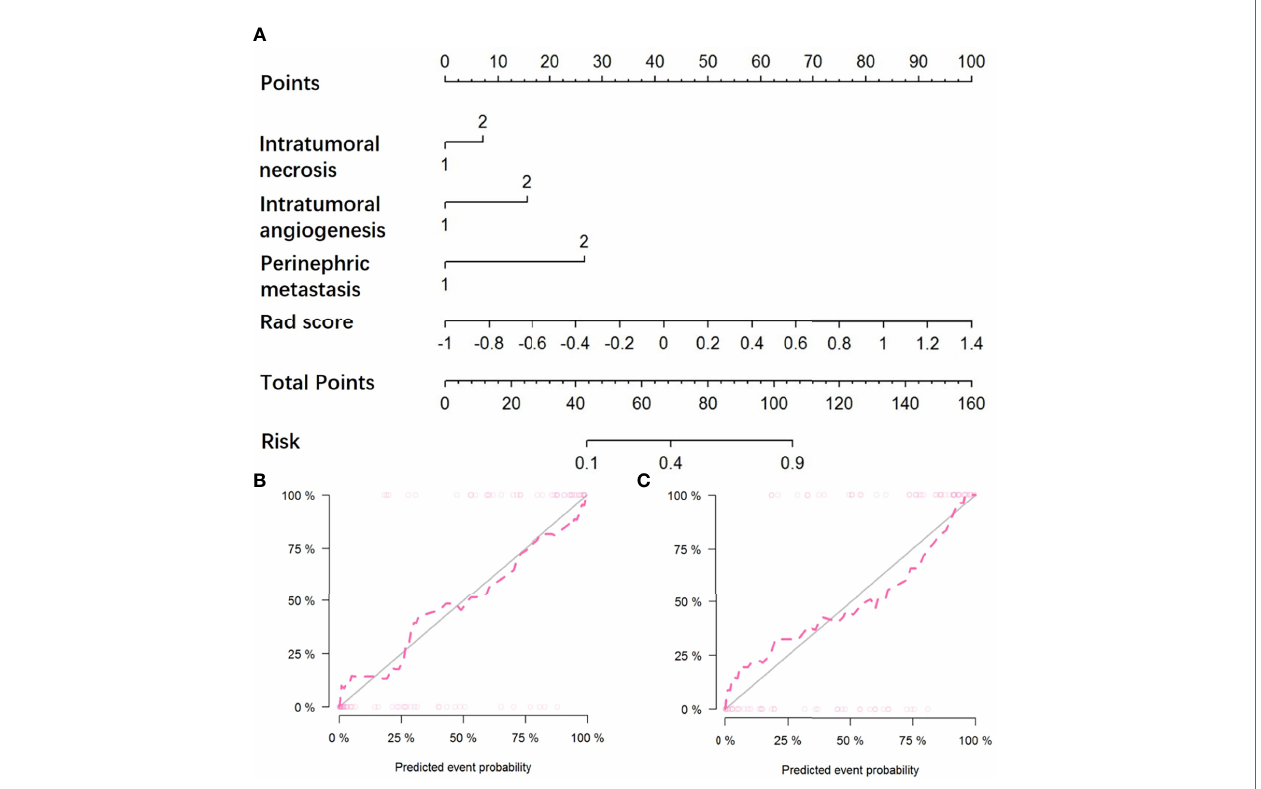
FIGURE 4 | The CT-based radiomics nomogram and calibration curves of the nomogram. (A) Integrating radiomics signature, intratumoral necrosis, intratumoral angiogenesis, and perinephric metastasis, the CT-based nomogram was established. Calibration curves of the nomogram in the training (B) and testing (C) sets.